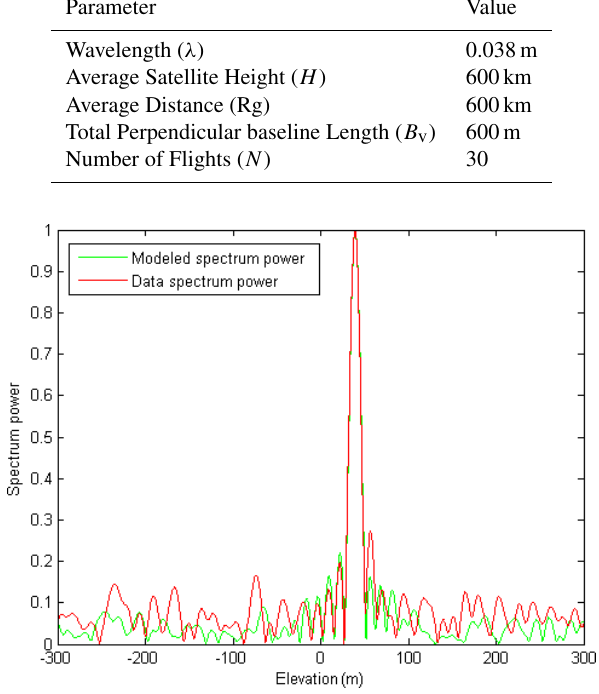
Figure 1. The results of Single Scatterers Simulation.